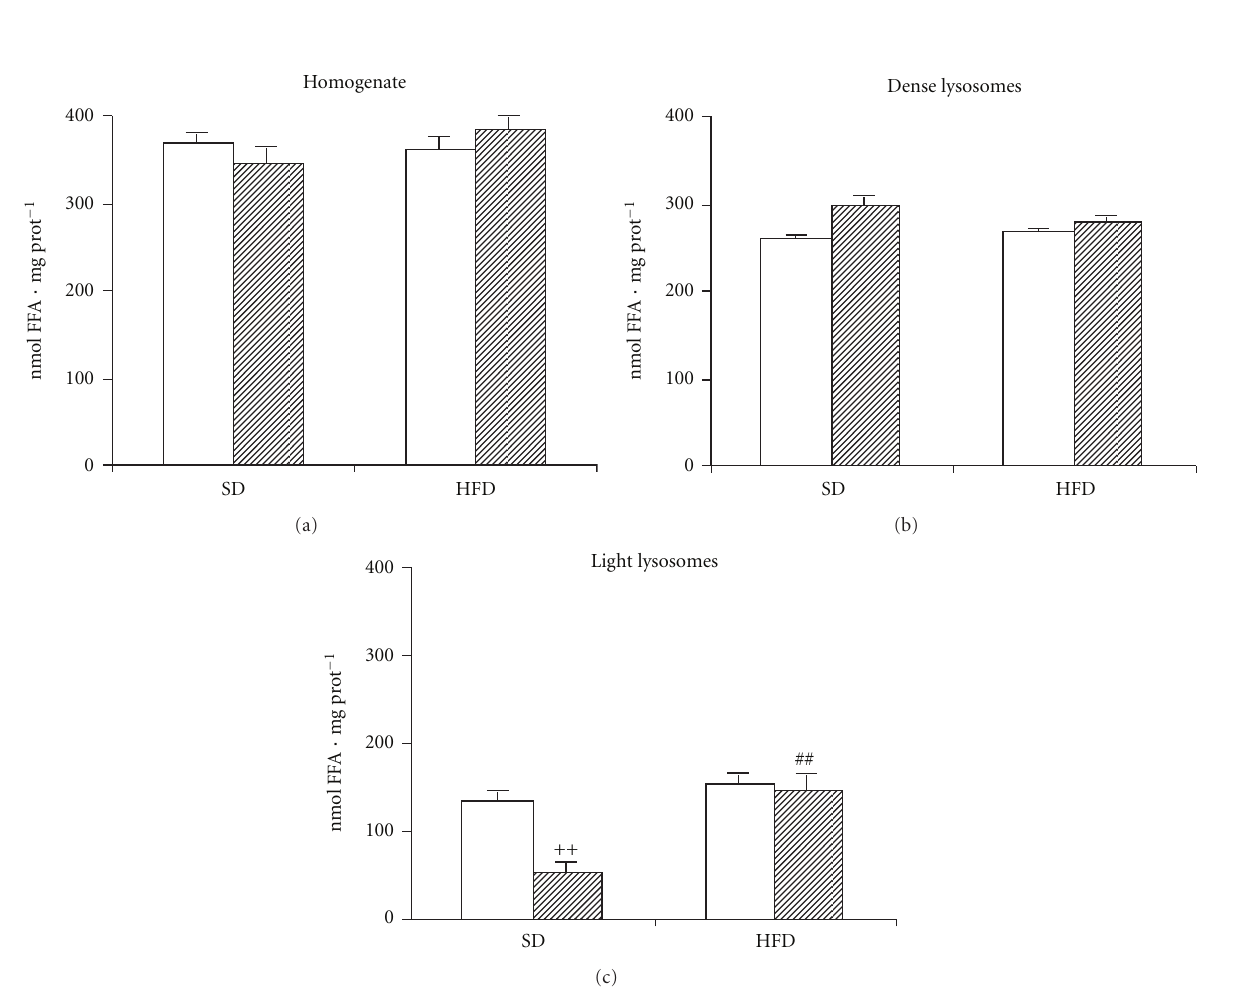
Figure 1: The e ff ect of HFD on the LIPA activity measured as FFA release from artificial substrate ( 3 H-triolein). (a) Homogenate; (b) dense lysosomes; (c) light lysosomes. The lipase activity was measured as the release of fatty acids at pH = 4.5 from 3 H-triolein. Open bars = fasted animals; hatched bars = fed animals. ++ P < 0 . 01 fed versus fasted; ## P < 0 . 01 HFD fed versus SD